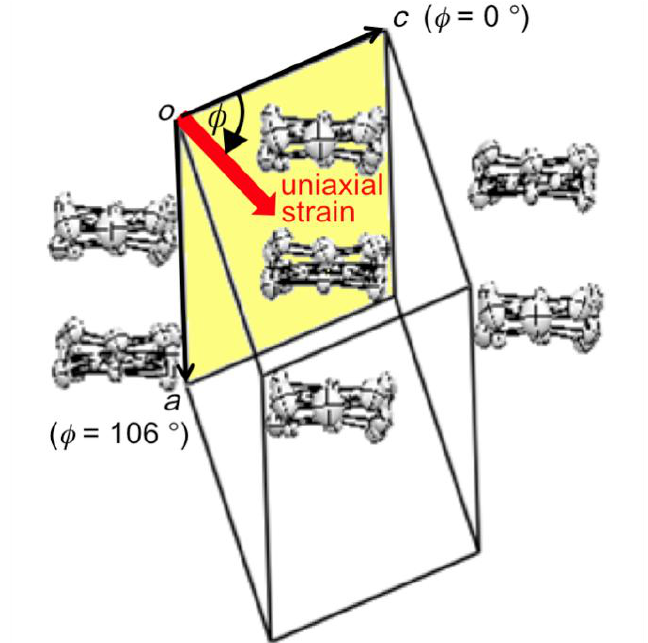
Figure 8. Definition of the orientation of uniaxial strain in the ac plane of β-(BDA-TTP) According to the definition, the orientations of the c -axis, a -axis and − a -axis strains are assigned by φ = 0°, 106° and −74°, respectively (Reprinted with permission from reference 21, American Chemical